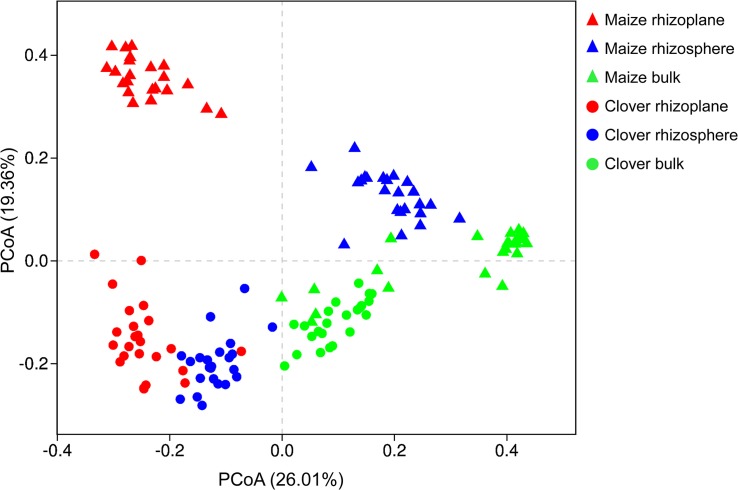
Bacterial communities in different rhizocompartments (rhizoplane, rhizosphere, and bulk) of clover and maize plants. Principal coordinate analysis (PCoAs) plots of the OTU-based Bray–Curtis distance between all samples. The variance explained by each PC axis is given in parentheses.